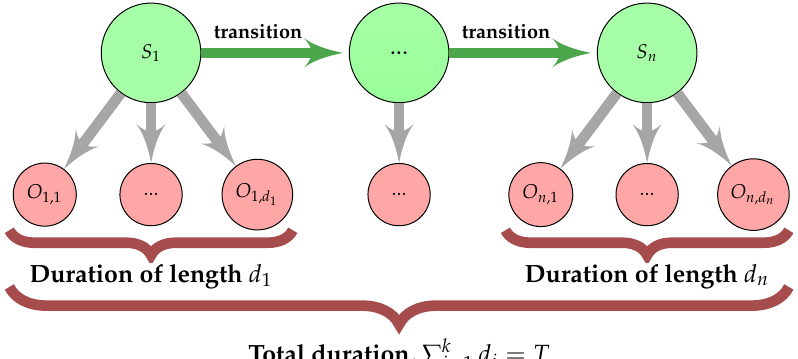
Figure 8. General scheme of hidden semi-Markov model. The model consists of hidden states S representing regions of the SP with the length distribution given by the state duration d . The hidden states emit observations O which are amino acid residues.